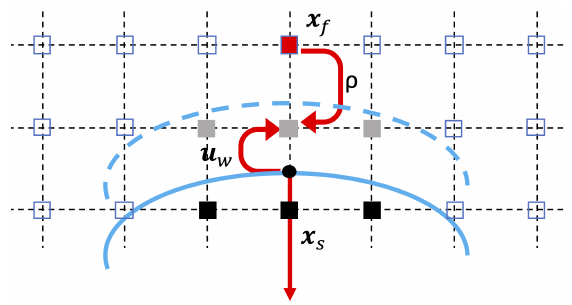
Figure 2. Schematic representation of refilling procedure. The obstacle, initially located at the dashed cyan line (new position is the solid cyan line) frees some nodes, the gray filled ones, which belonged to the solid. Their new fluid-dynamics properties are copied from both red filled fluid node x f and solid one x s